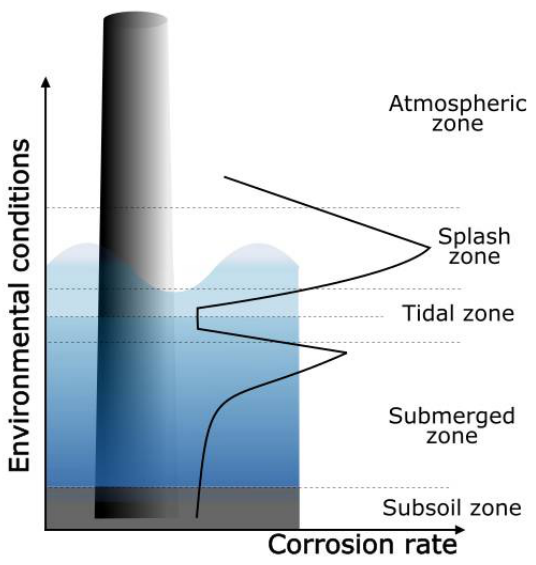
Figure 1. Zones of corrosion and relative corrosion rate depending on the exposure zone.